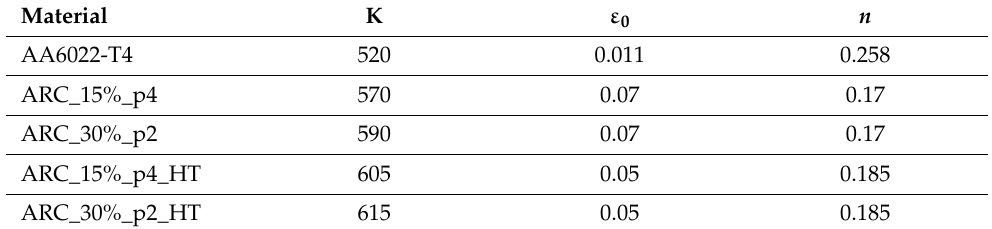
Table 5. Determined Swift parameters.